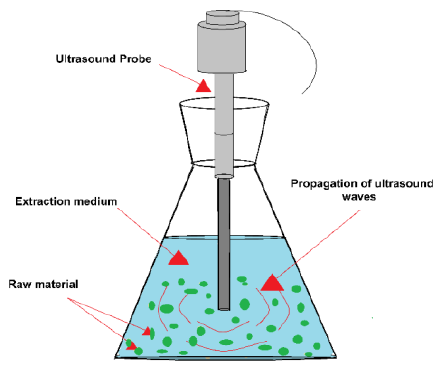
Figure 4. Representation of an Ultrasound system coupled to a probe. Modification from Barba et al.